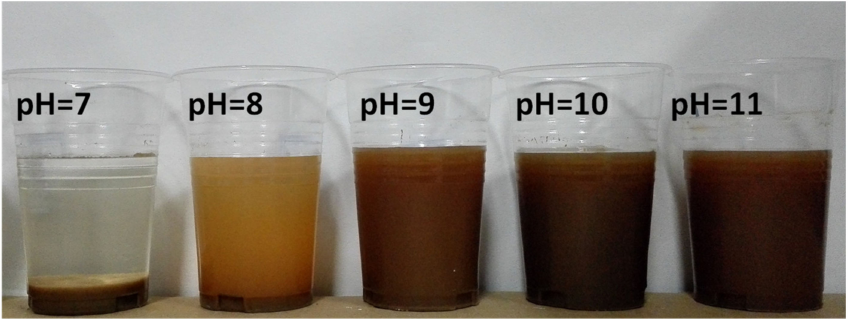
Figure 13. Stability of slurry of T2 at different